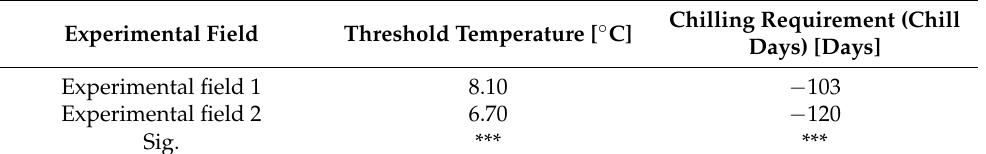
Table 4. Mean threshold temperatures and chilling requirements, registered in the experimental field